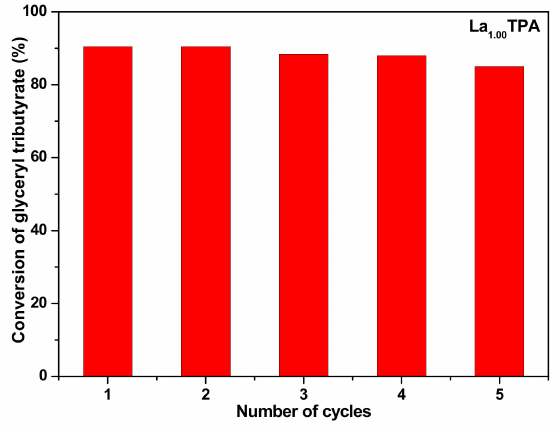
Figure 8. Reusability of La 1.00 TPA